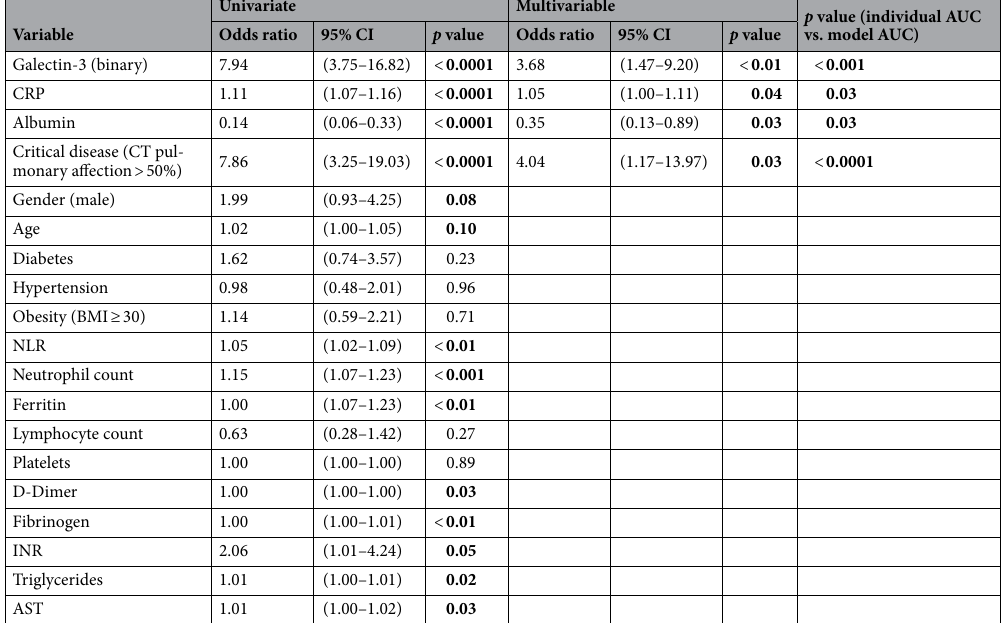
Table 3. Univariate and multivariable logistic regression analyses for severe outcome. Galectin-3 was analyzed as a binary variable according to its non-linear relationship with severe outcomes (> 30.99 ng/ mL = 1, < 30.99 ng/mL = 0). Only variables with a p value < 0.20 after univariate analyses were further evaluated in multivariable analyses. The AUC of the final model was compared against that of each independent predictor with DeLong’s test for correlated ROC curves. Bold values represent p <